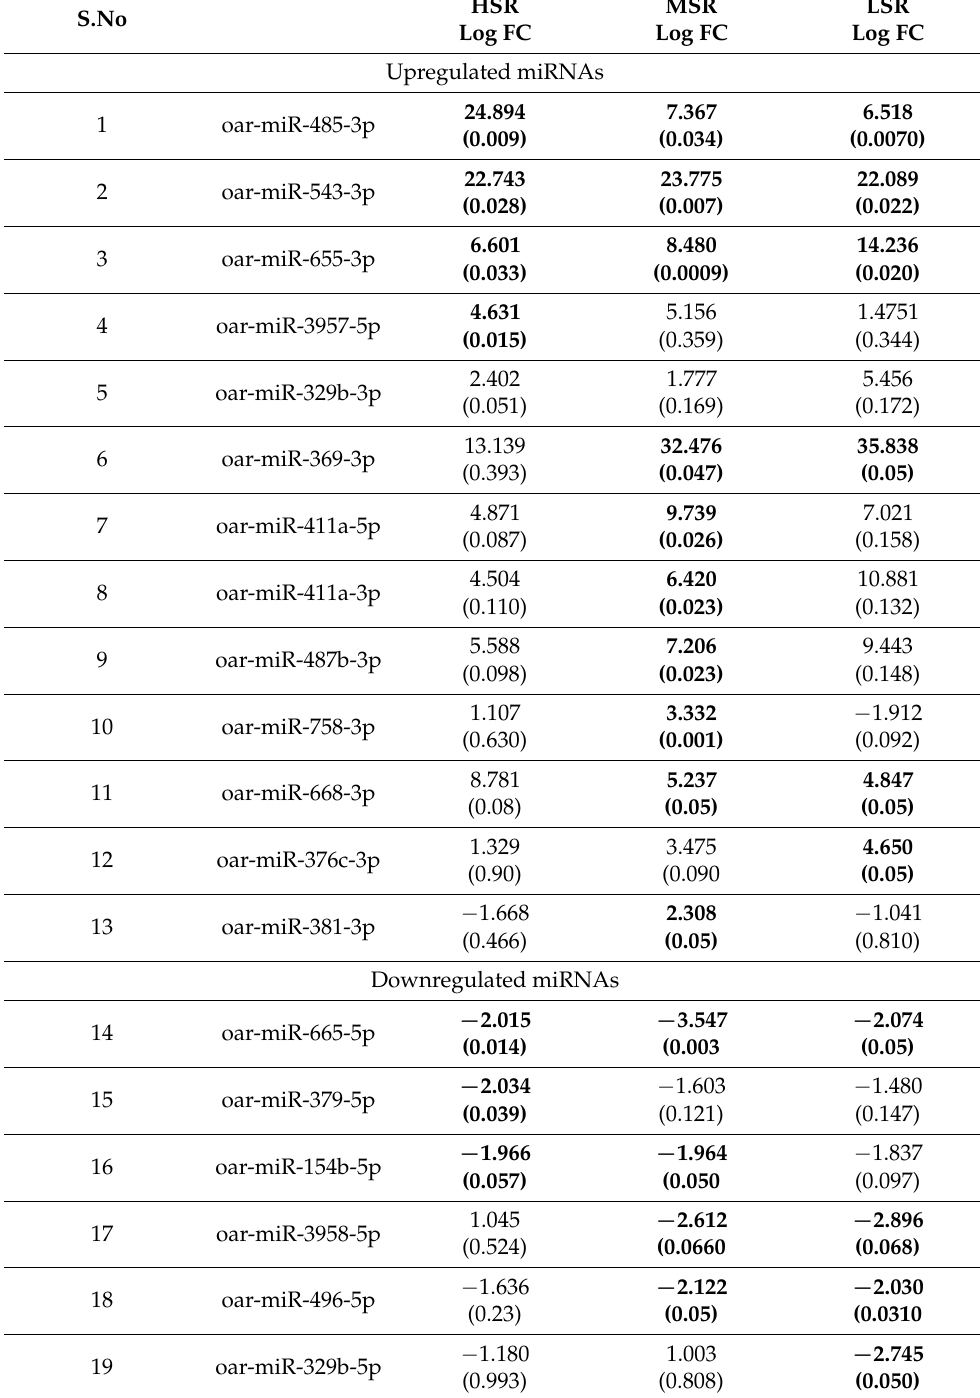
Table 1. Differentially expressed (T4 versus T0) ovine serum miRNAs post-LPS immune challenge for HSR, MSR, and LSR sheep. Values represent fold change (FC) followed by the corresponding p -value. S.No